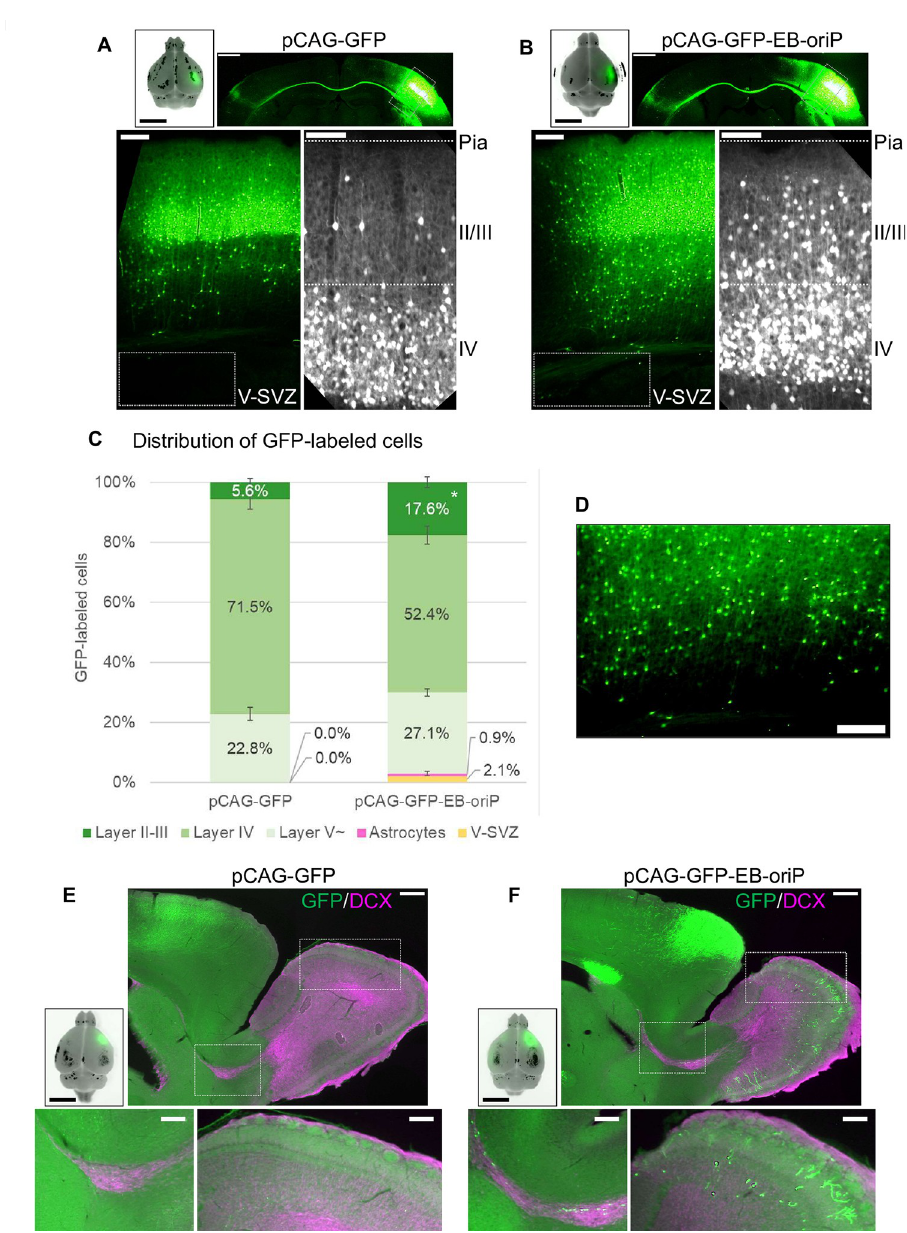
Fig 4. Transgene expression in neurons in a broad range of layers but few in astrocytes and cells in V-SVZ by IUE of the EB-oriP plasmid at E13. (A and B) GFP fluorescence images of coronal sections from the brains transfected at E13 with pCAG-GFP (A, upper right) and pCAG-GFP-EB-oriP (B, upper right) and observed at P21. Merged images of GFP fluorescence and bright-field image of the brains used for sections are shown in the upper left panels. The boxed regions were magnified and shown in the lower left panels, respectively. Magnified GFP fluorescence images of the superficial region are shown in the lower right panels. Scale bars: 5 mm in upper left panels, 1 mm in upper right panels, 200 μ m in lower left panels, 100 μ m in lower right panels. (C) Quantification of the distribution of GFP-labeled cells (pCAG-GFP, n = 2054; pCAG-GFP-EB-oriP, n = 4359, from three mice). Two to three sections from the central part of the transfected region per animal were counted. Data represent mean ± SEM. � P < 2.2e–16, compared with pCAG-GFP (Fisher’s exact test). (D) Magnified GFP fluorescence images of the deeper layer region of pCAG-GFP-EB- oriP-transfected brain, showing few GFP-labeled astrocytes. Scale bar: 200 μ m. (E and F) Sagittal sections from the brains transfected at E13 with pCAG-GFP (E) and pCAG-GFP-EB-oriP (F) and fixed at P21 were immunostained for DCX. Merged images of GFP fluorescence and bright-field image of the brains used for sections are shown in upper left panels. The boxed regions in RMS (left) and OB (right) were magnified and are shown in lower panels. Scale bars: 5 mm in upper left panel, 500 μ m in upper right panel, 200 μ m in lower